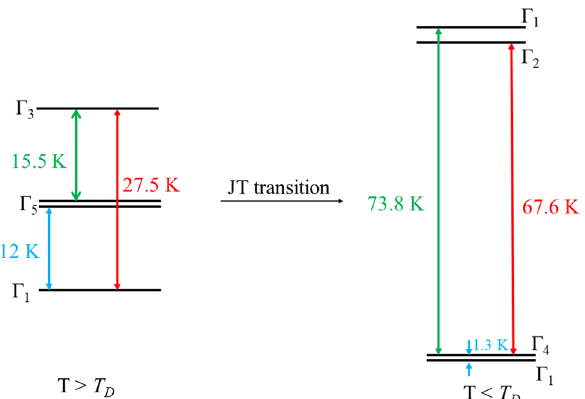
Figure 5. Energy level diagram for TbVO 4 below and above the structural transition